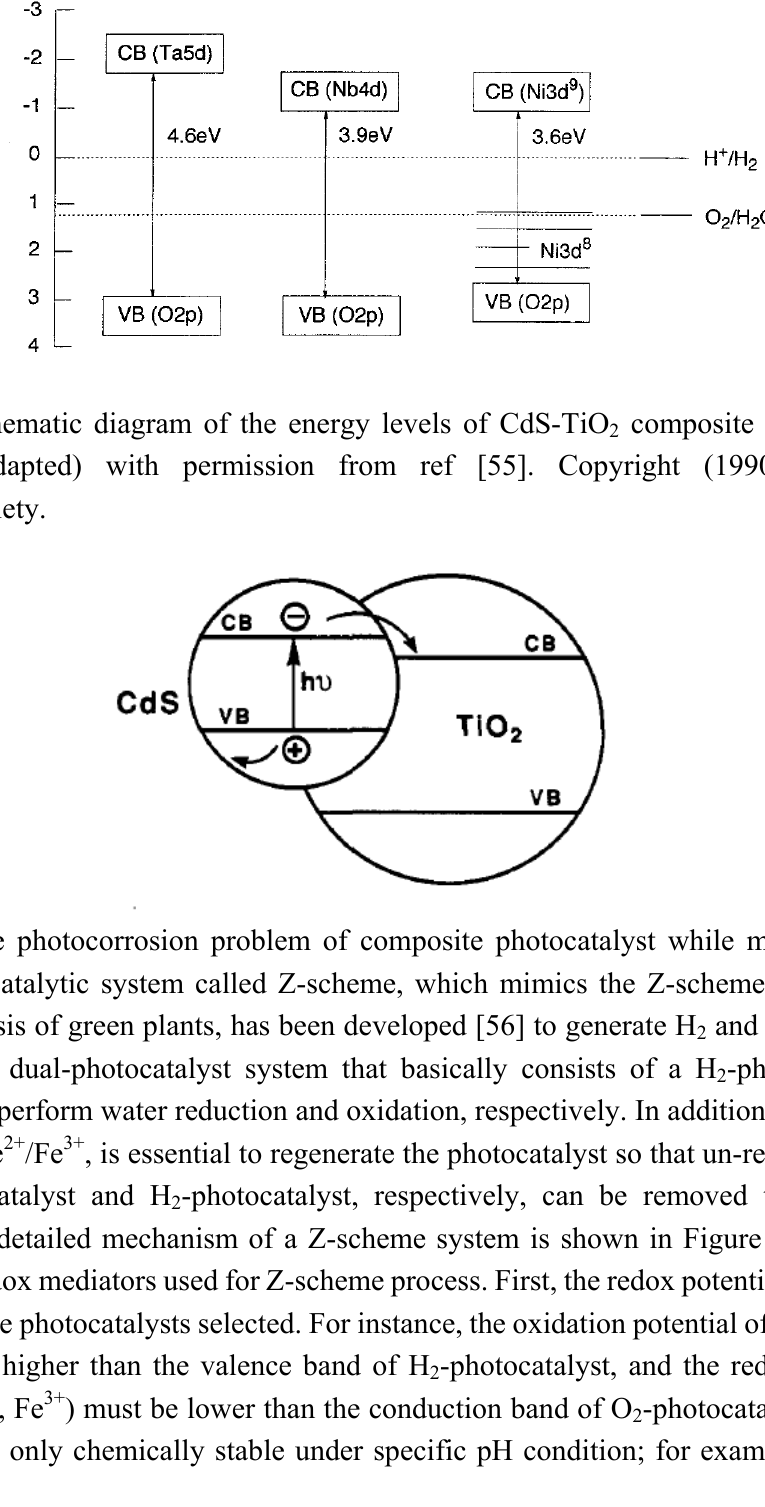
M O (M = Nb and Ta) photocatalysts and NiO 2 2 7